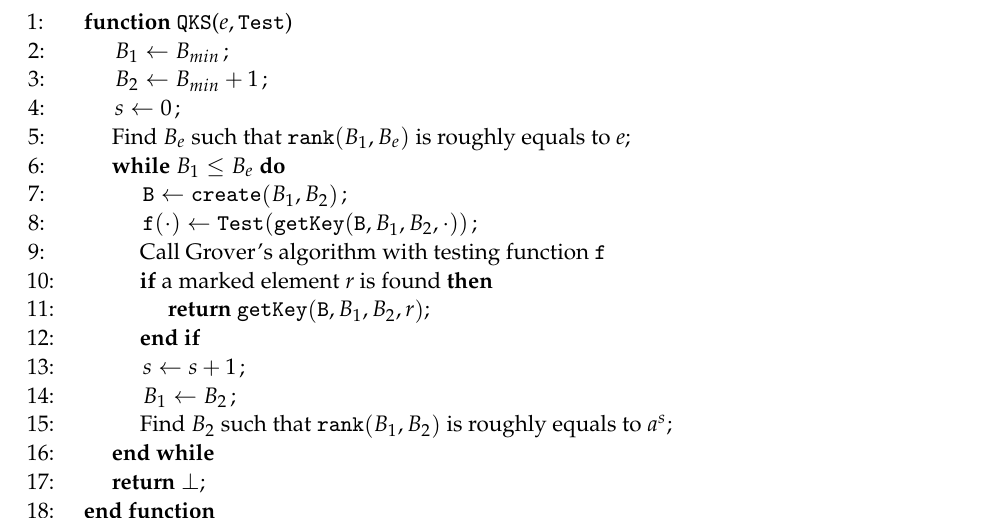
Algorithm 11 performs a quantum key enumeration over an interval with roughly e full key